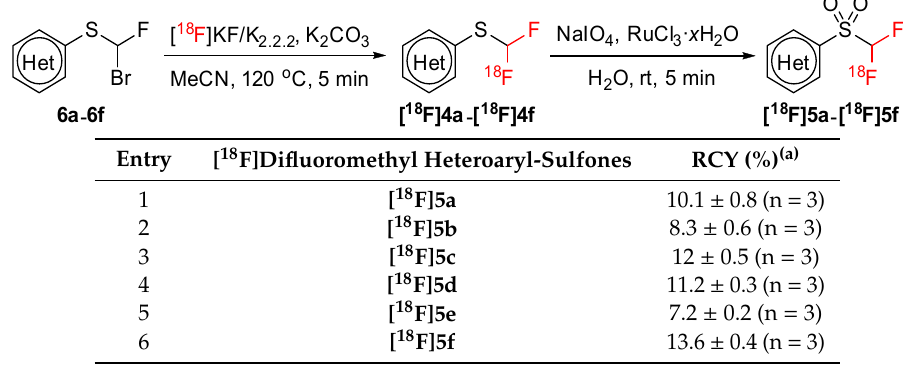
Figure 3. Layout of the FASTlab TM cassette for the radiosyntheses of the labeled compounds [ 18 F]5a , [ 18 F]5c , and [ 18 F]5f